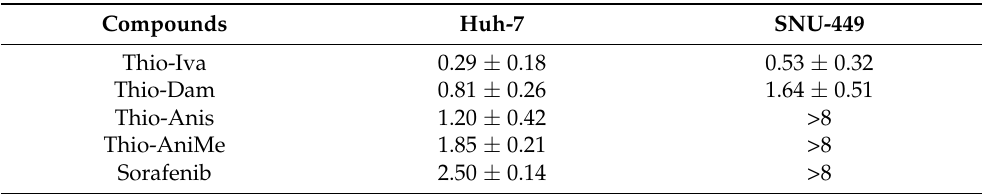
Table 1. Determination of IC 50 values ( µ M) of test compounds for the Huh-7 and SNU-449 HCC cell lines after incubation for 48 h.